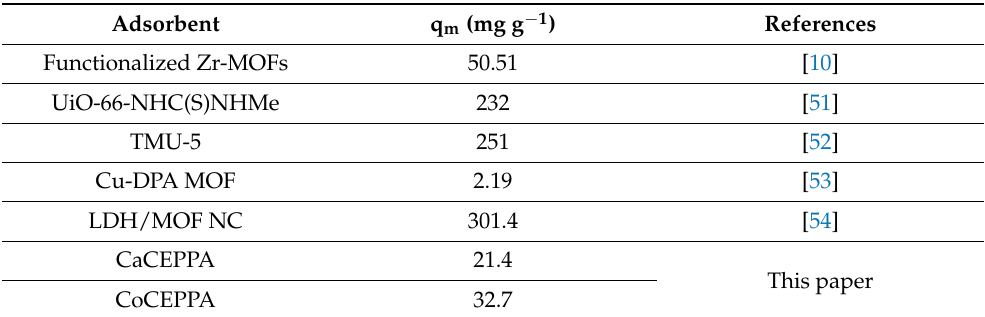
Table 4. Comparison of the maximum adsorption capacities given/demonstrated by similar adsor- bents in the treatment process of aqueous solutions containing Pb 2+